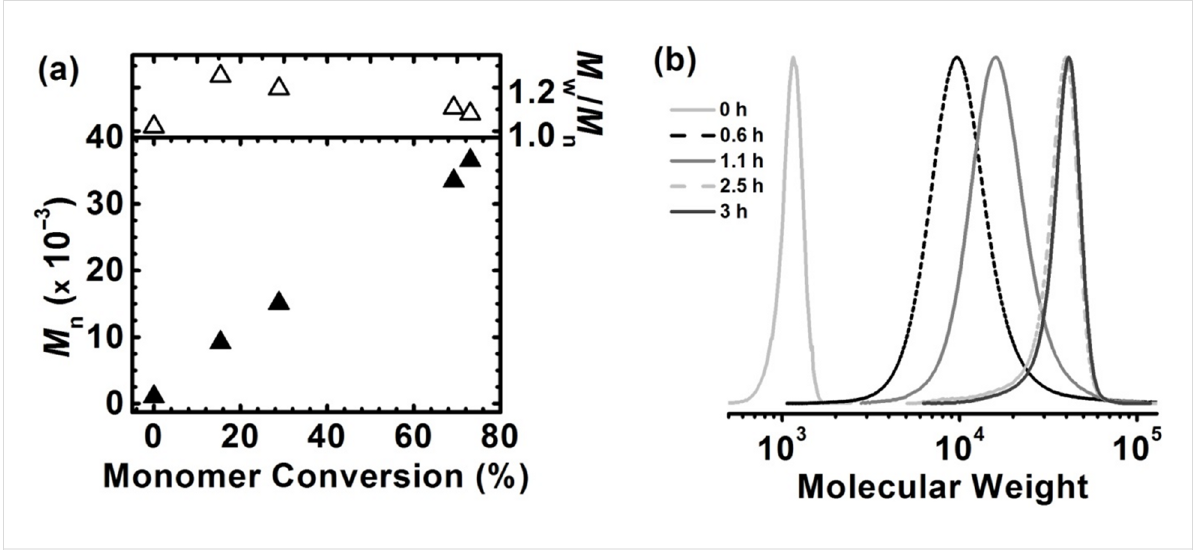
Figure 2: Synthesis of P t BA homopolymers grafted from quercetin-based macroinitiator via se ATRP under constant potential conditions; (a) M n and M w / M n vs monomer conversion, and (b) GPC traces of t BA polymerization and their evolution over time . Reaction conditions: [ t BA]/[QC-Br 5 (per 5 ini- tiation sites)]/[Cu II Br 2 ]/[TPMA] = 110/1/0.011/0.022, [ t BA] = 3.4 M, [Cu II Br 2 /TPMA] = 0.34 mM, [TBAP] = 0.2 M, T = 65 °C. Table 1, entry